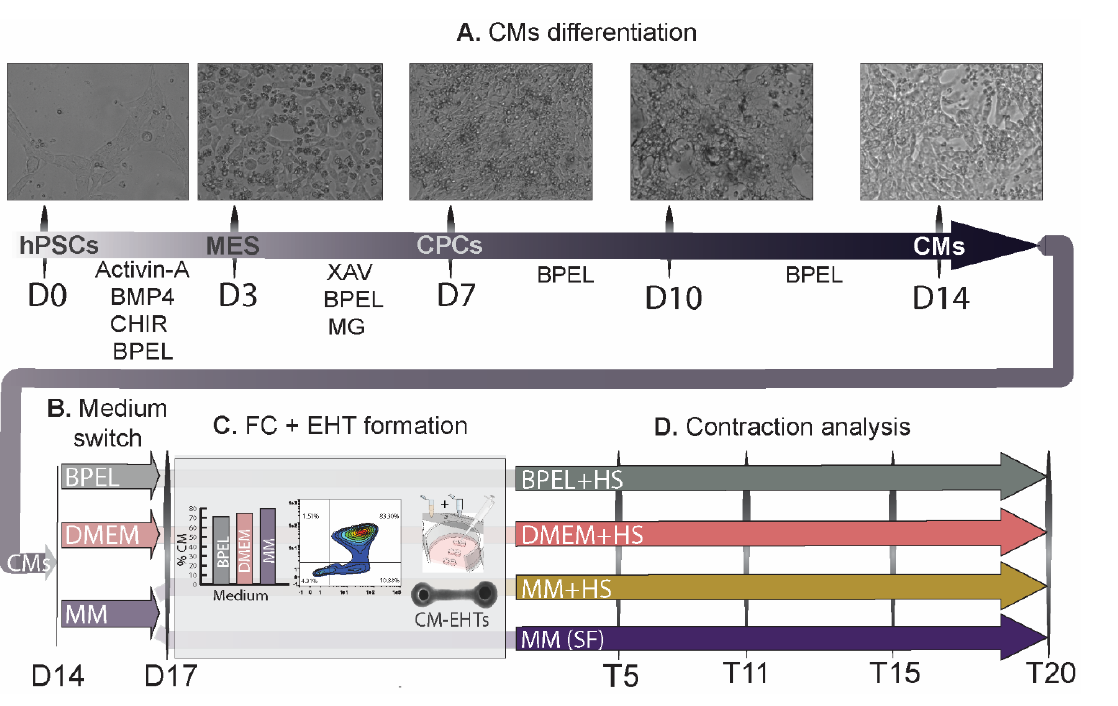
Figure 1. Representative differentiation to CMs from hPSCs and experimental flow chart. ( A ) CM differentiation steps at day 0 (D0), 3 (D3), 7 (D7), 10 (D10), and 14 (D14). ( B ) Medium switch on fully differentiated CMs at day 14 to BPEL, DMEM, or Maturation Medium (MM) until day 17 (D17). ( C ) At day 17, flow cytometry (FC) was performed in CMs from the three different groups, followed by tissue formation in the corresponding media with or without horse serum (HS and SF, respectively). ( D ) Following contraction analysis carried at day 5, 11, 15, and 20 after tissue formation (T5, T11, T15, and T20). Drug tests were performed at the best timepoint of force of contraction assessed (day 10 (D10)). After 21 days of tissue formation (T21), tissues were kept for histological analysis. HPSCs, human pluripotent stem cells; MES, mesoderm; CPCs, cardiac progenitor cells; CMs, cardiomyocytes; MG, Matrigel; HS, horse serum; and SF, serum-free.